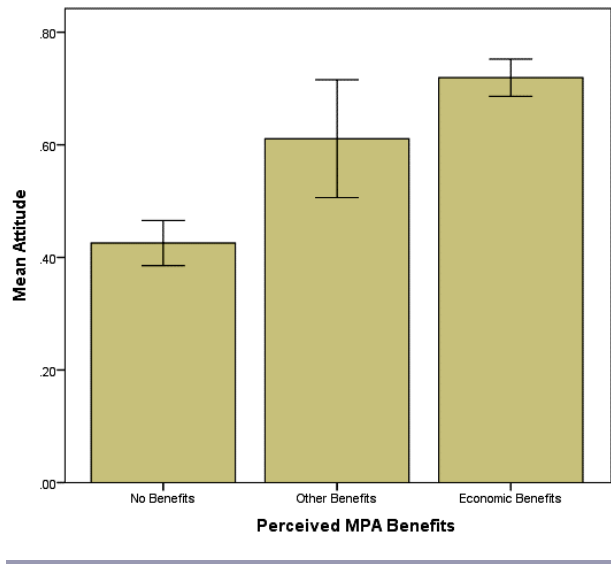
Fig. 3 . Differences in attitudes among individuals who perceived various MPA benefits. MPA indicates marine protected area.